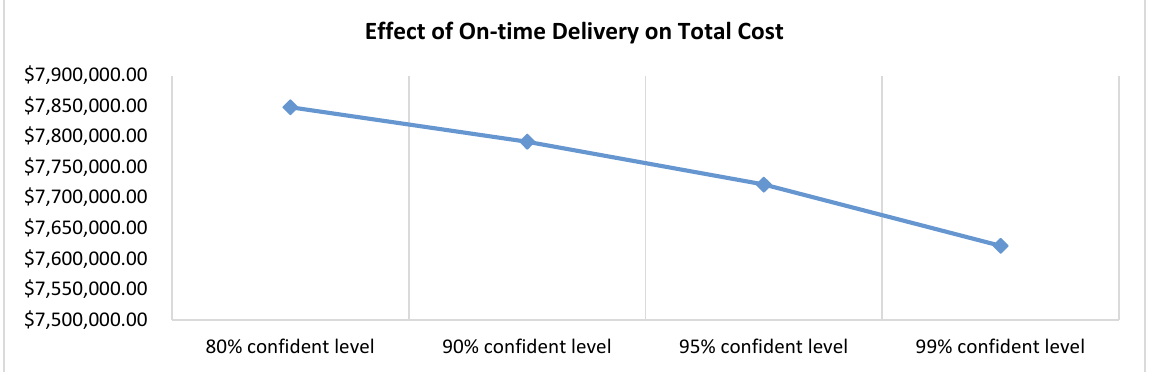
Fig. 5. Effect of On-time Delivery on Total